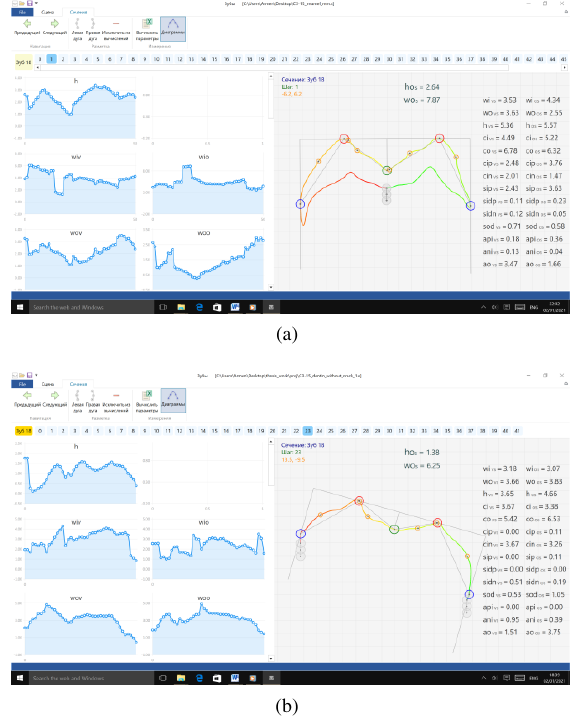
Figure 4. Measurements on enamel cap (a) and dentin (b)